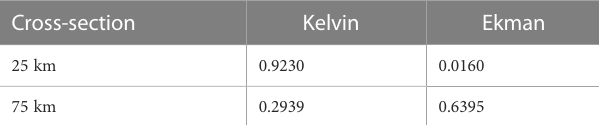
TABLE 3 The time-averaged values of nondimensional vertical Ekman and Kelvin numbers in the cross-sections at 25 km and 75 km in EXP6. Cross-section